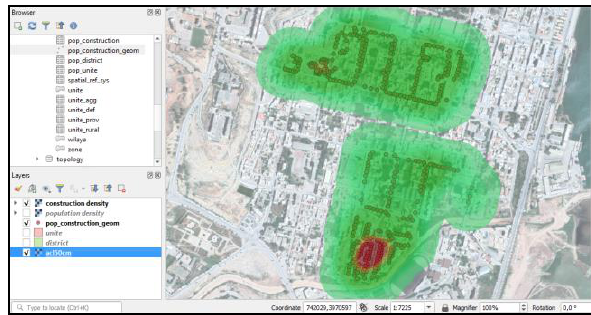
Figure 6. Representation of the density of construction. The second map represents the visualization of the population distribution at the community level that is collected on the ground by the census taker